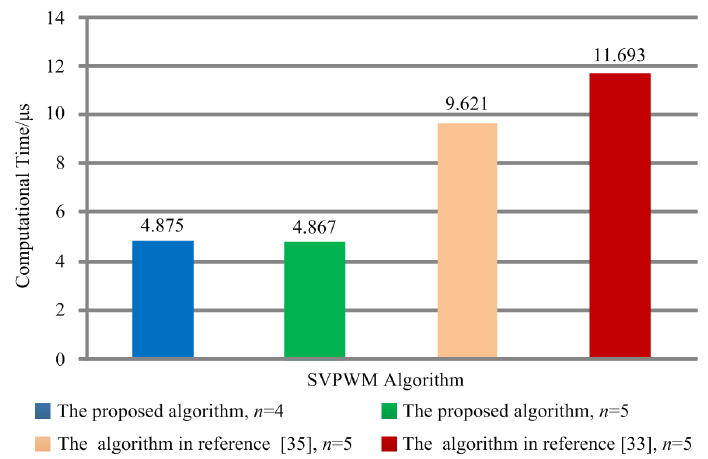
Figure 17. Computational times of the three SVM schemes in the DSP.